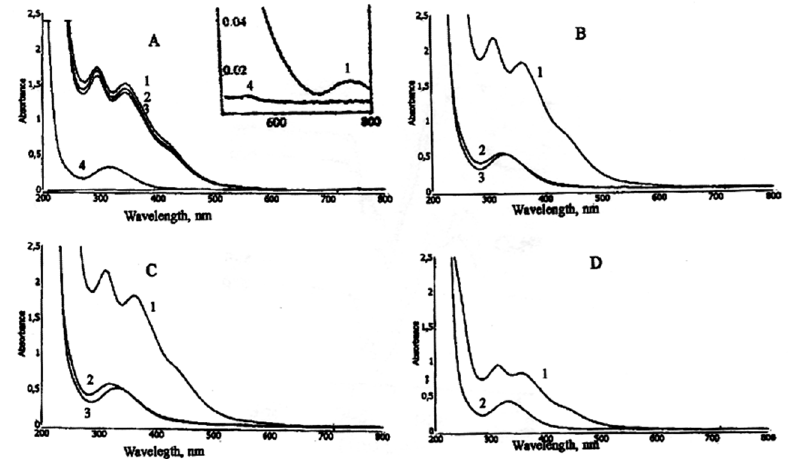
Figure 10. The decomposition of B-DNIC-GSH and their conversion into GS-NO induced by heating acidified solutions. ( A ) the optical absorption spectra recorded 2 and 30 min after acidification of the initial 0.4 mM solution of B-DNIC-GSH (pH 7.4) (curve 1) to pH 1.0 (curves 2 and 3, respectively) and a subsequent 30-s increase in temperature to 80 °C in the air (curve 4). Inset: the weak absorption bands of GS-NO and B-DNIC-GSH at 543 and 768 nm (curves 4 and 1, respectively). ( B , C ) the optical absorption spectra recorded after acidification of a 0.5 mM solution of B-DNIC-GSH to pH 1.0 (curve 1) and 30-s heating at 80 °C ( B ) or 25 min incubation at 40 °C ( C ) in the presence and absence of air (curves 2 and 3, respectively). ( D ) the absorption spectra of a 9 mM B-DNIC-GSH acidified to pH 1.0 recorded after a 40-fold dilution with distilled water (curve 1) and 15-min incubation at 80 °C in the air followed by a 20-fold dilution of the final solution with distilled water (curve 2) [40]. (With permission).